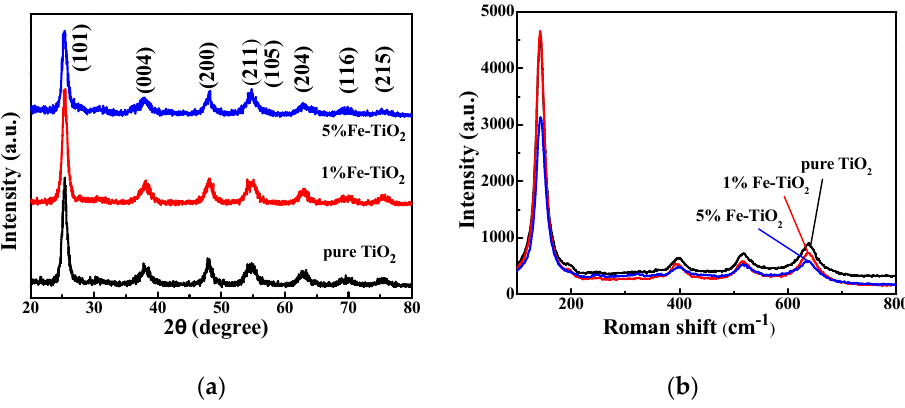
Figure 5. ( a ) XRD spectra of pure TiO 2 and Fe-TiO 2 ; ( b ) Raman spectra of pure TiO 2 and Fe-TiO 2 .